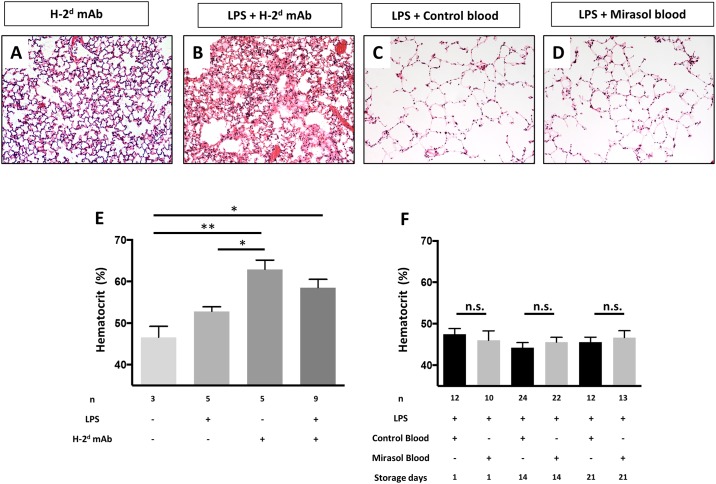
Representative lung histology and hematocrit values.H&E staining on lung sections from (A) BALB/c SCID mice + H-2d mAb, (B) BALB/c SCID mice + LPS priming + H-2d mAb, (C) BALB/c SCID mice + LPS priming and a 25% exchange transfusion using control human whole blood (storage day 21), and (D) BALB/c SCID mice + LPS priming and a 25% exchange transfusion using Mirasol-PRT treated human whole blood (storage day 21). Extensive lung injury (interstitial and alveolar edema, leukocyte infiltration) is observed in the TRALI groups (A, B), but no lung injury is detectable in either group of mice transfused with human whole blood (C, D). 20x magnification. (E) Hematocrit values in blood samples obtained from controls, TRALI, and (F) human whole blood challenged animals. Hemoconcentration is observed with TRALI, but not in the other groups. Mean ± SEM. ****p<0.0001, **p<0.01 (ANOVA).